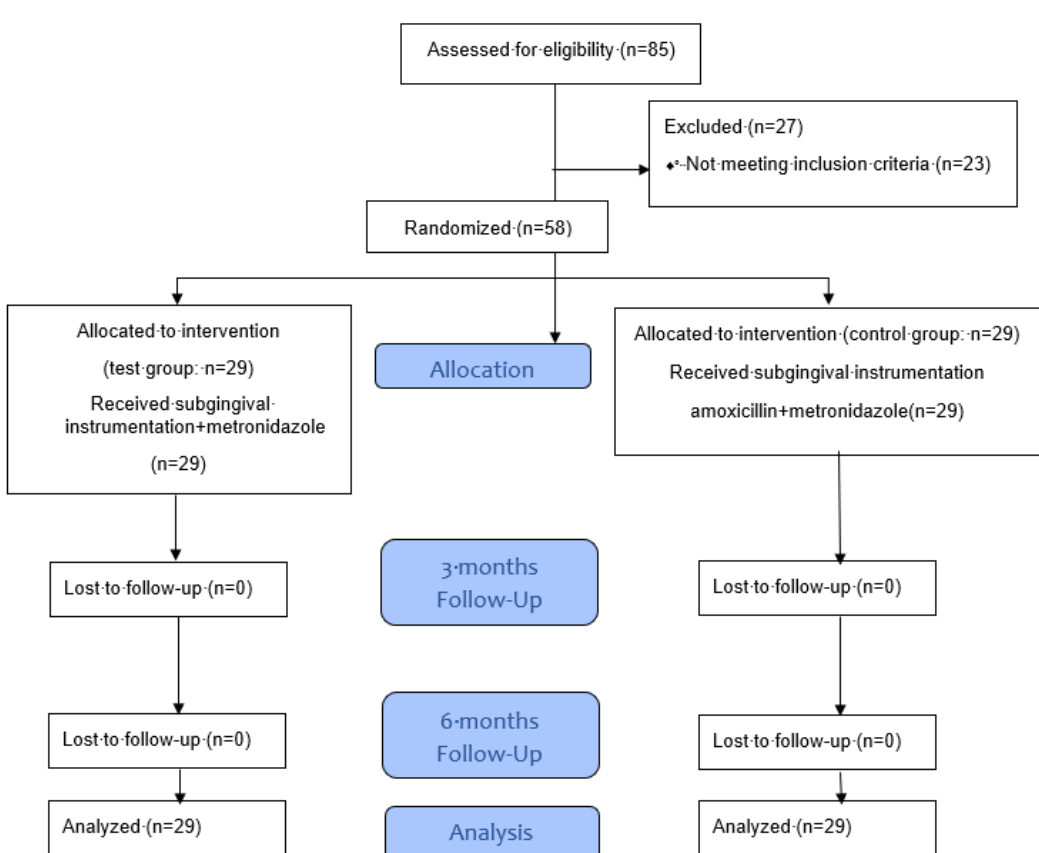
Figure 1. Flowchart (adapted to Moher et al. [29]) of the study non-surgical periodontal therapy with adjunctive amoxicillin / metronidazole or metronidazole in the absence of Aggregatibacter actinomycetemcomitans —a randomized clinical trial.